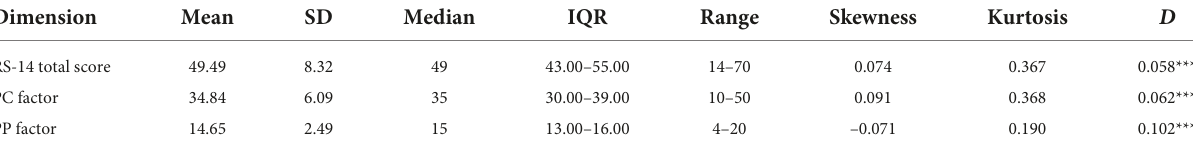
TABLE 4 Descriptive statistics and test results for normality of RS-14 ( n = 7,231). Dimension